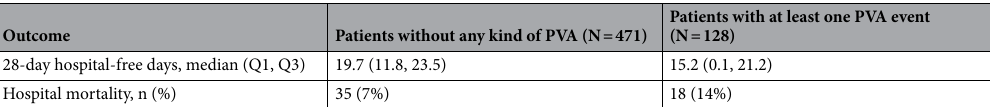
Table 4. Post-extubation or -weaning success outcomes (n = 599). Patients who died on ventilator (n = 97) were excluded from the analysis. We describe hospital-free days through 28 days—defined as the number of days alive and out of hospital during 28 days after extubation or weaning success. Weaning success was defined as patients who received tracheostomy and no longer required mechanical ventilation. PVA patient ventilator asynchrony.